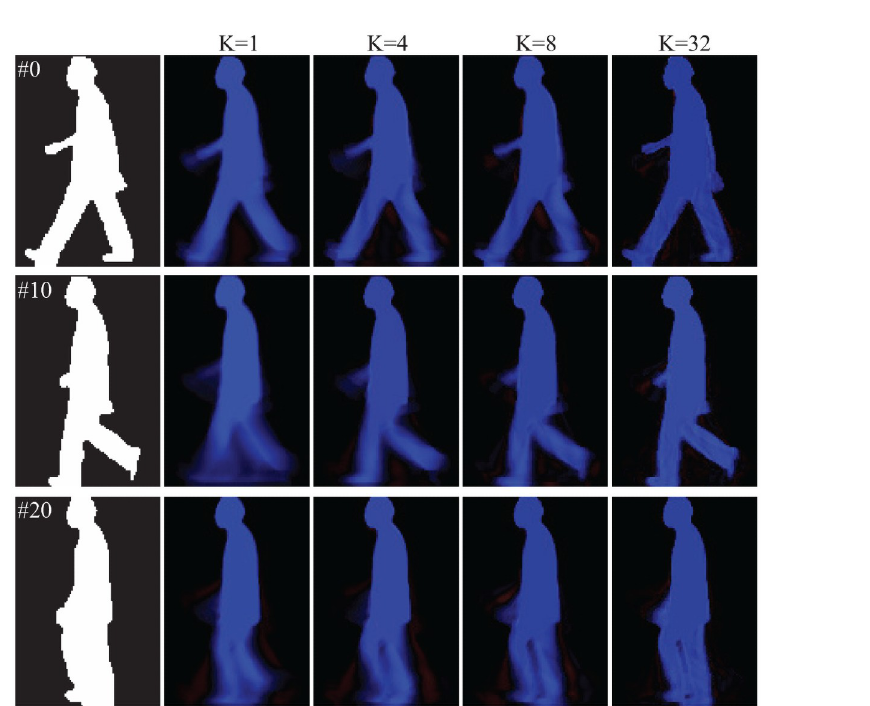
Fig 8. Examples of reconstructed images with K = 1, 4, 8, 32 by the PCA.